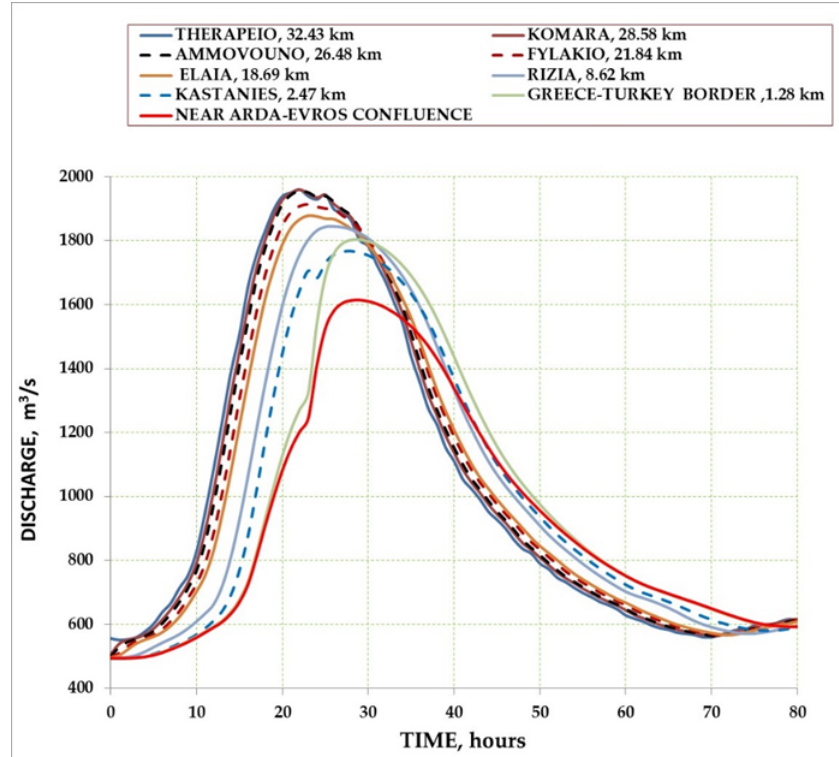
Figure 5. Discharge hydrographs between levees as a function of time at various cross-sections along the